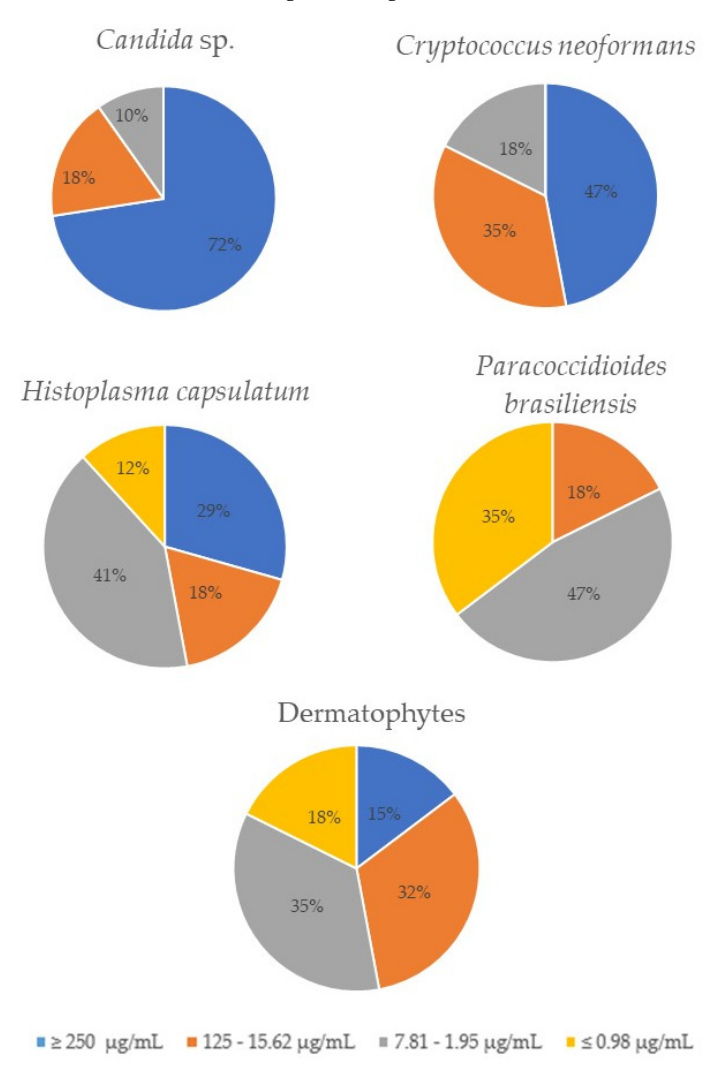
Figure 2. Representative graphs of the MIC 90 obtained for each fungal species, for the 17 tested nitrofuran derivatives.